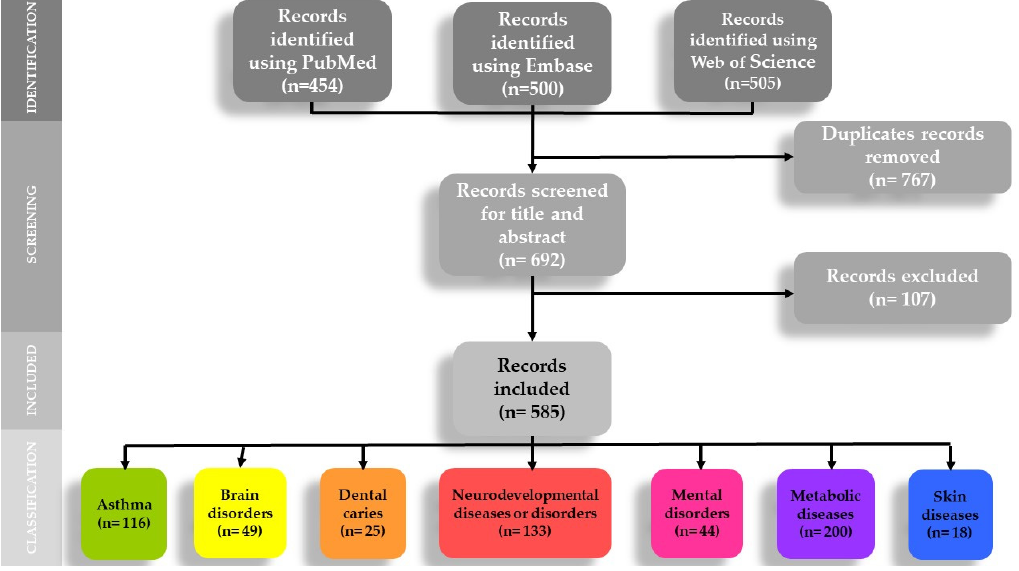
Figure 1. PRISMA flowchart of the selection process and classification process by topic of the included records.